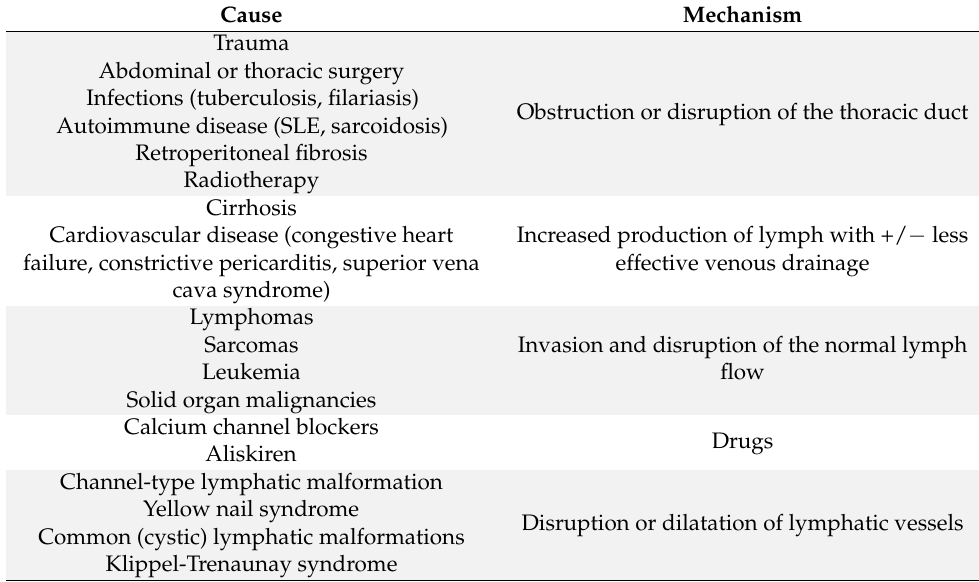
Table 1. Causes of